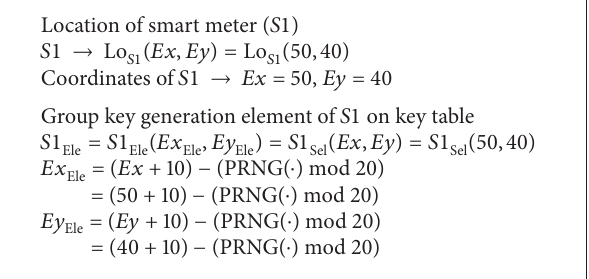
Algorithm 1: Example of selection of group key generation ele-